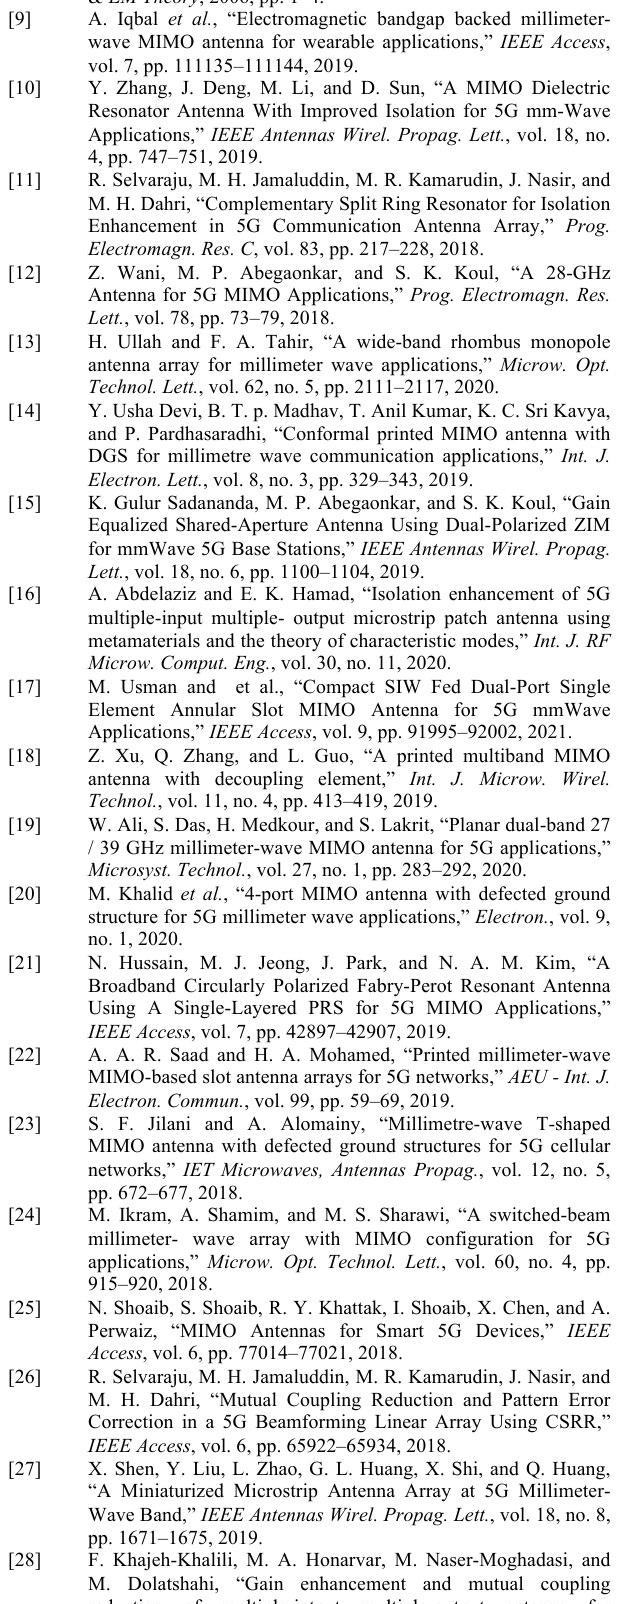
Table III and IV compare the performances of